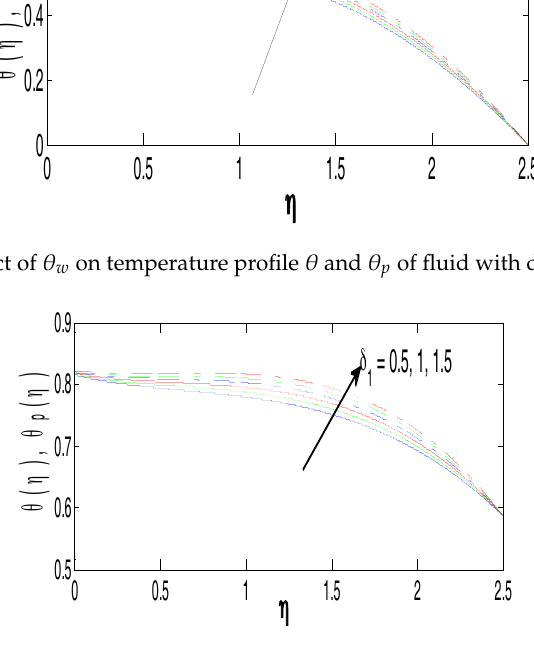
of fluid with dusty particles. p